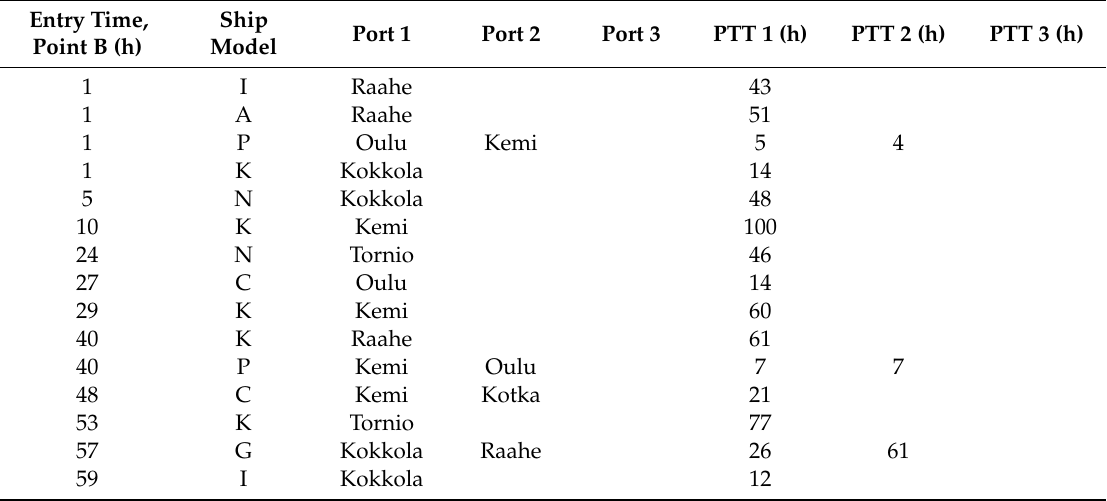
Table A1. List of ships arriving from Kvarken (Point A as per Figure